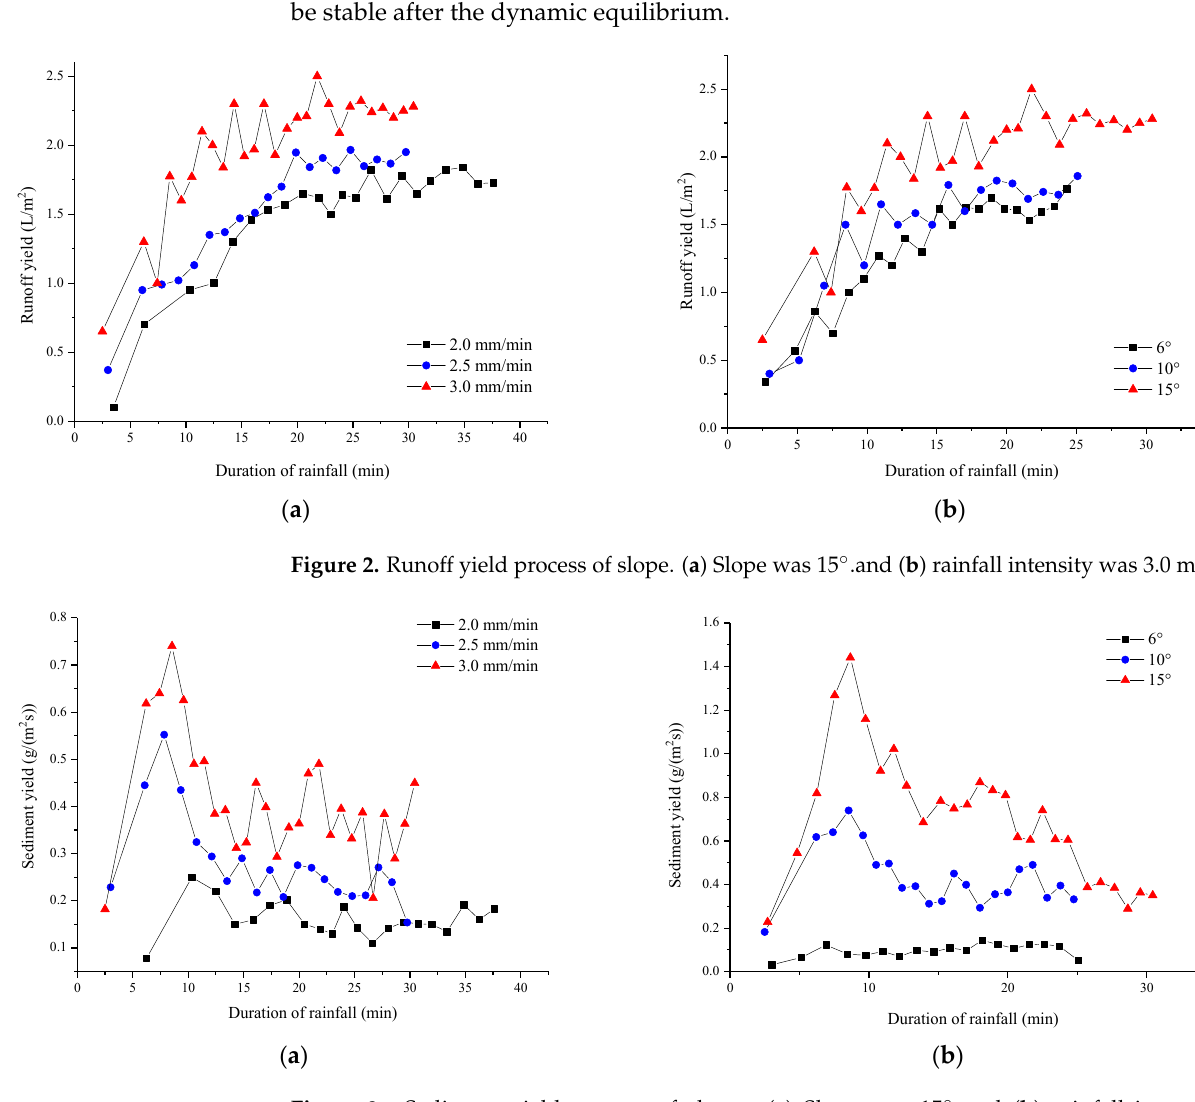
Figure 3. Sediment yield process of slope. ( a ) Slope was 15° and ( b ) rainfall intensity was 3.0 mm/min.